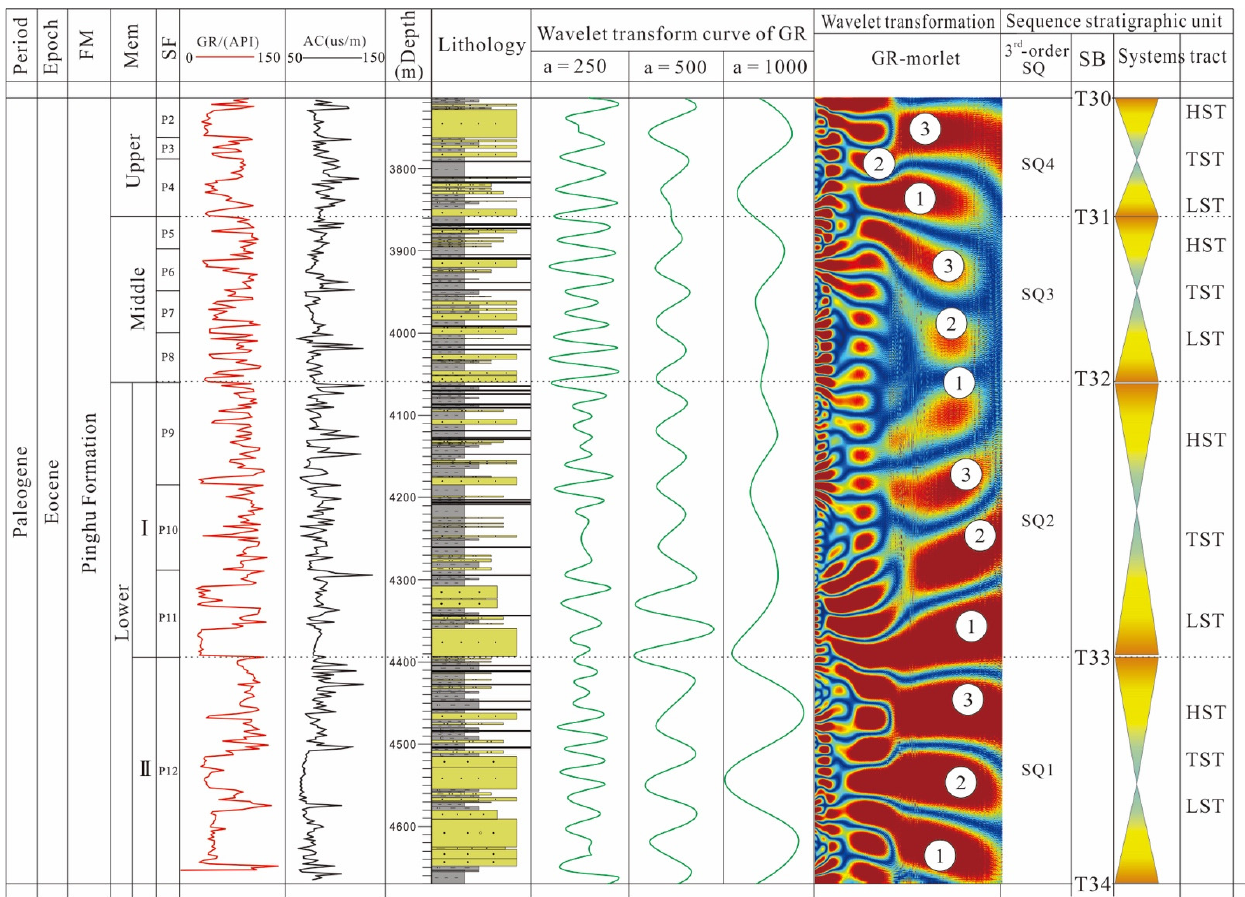
Figure 4. W-2 well logging and wavelet analysis of sequence boundaries in the Pinghu Formation of the Xihu Depression. Each third-order sequence exhibits a tripartite wavelet power signature (denoted as circled values 1–3 in the wavelet transform column) that corresponds to the three sys- tems tracts of that sequence.